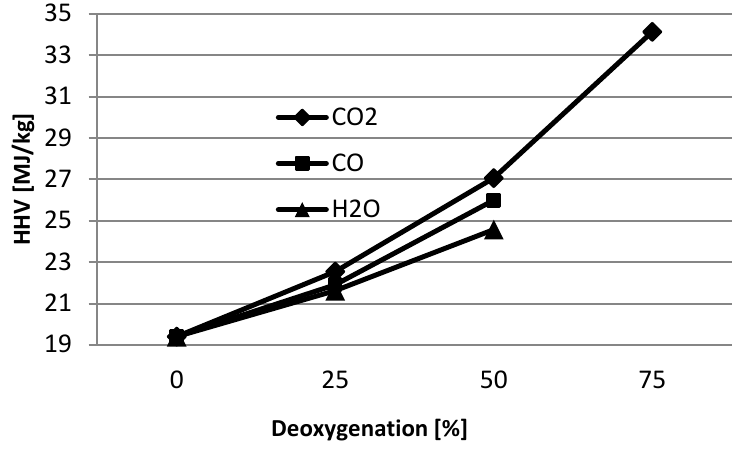
Figure 3. Effectiveness of different de-oxygenation routes to improve the heating value of the bio-oil.